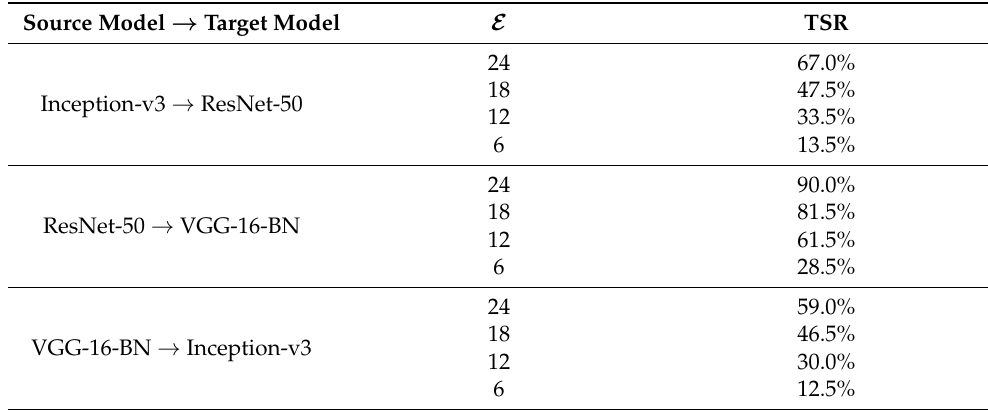
Table 5. QuEry Attack’s transferability on ImageNet models. TSR: Transferability Success Rate. Source Model → Target Model E TSR